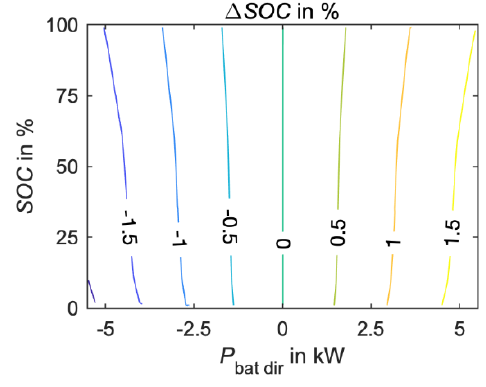
Figure 4. Characteristic map of the battery (1 min charging/discharging).